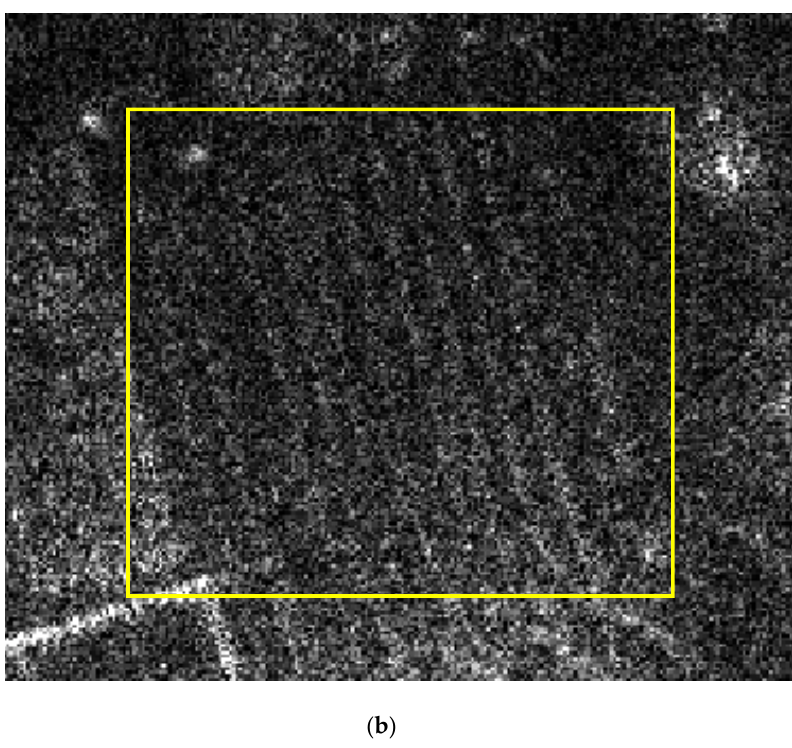
Figure 12. SAR images of coffee crop acquired on ( a ) 11 December 2018; and ( b ) 17 April 2019.